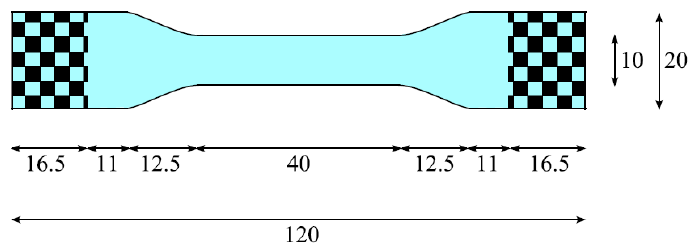
Fig. 4 Dimensions in [mm] of PVB specimens for uniaxial tensile testing; thickness of the specimen is 0.76